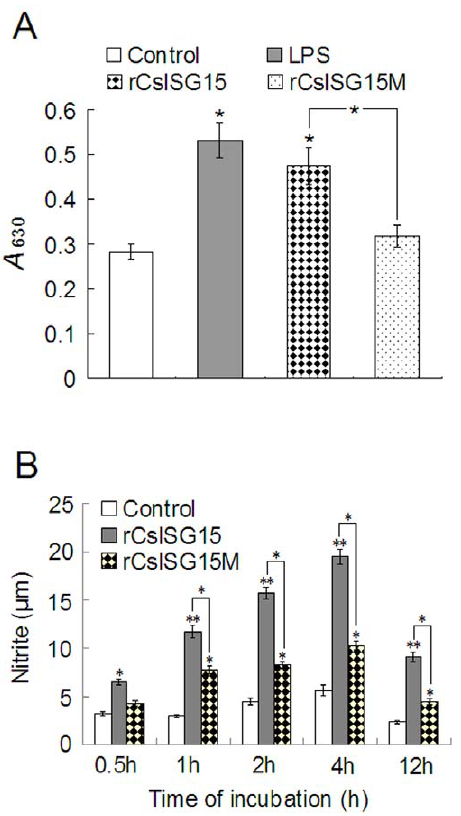
Figure 6. Effect of rCsISG15 and rCsISG15M on macrophage activation. (A) Tongue sole head kidney macrophages were treated with or without (control) rCsISG15, rCsISG15M, or lipopolysaccharide (LPS) for 2 h and examined for respiratory burst. (B) Tongue sole head kidney macrophages were treated with or without (control) rCsISG15 or rCsISG15M for different hours and examined for nitric oxide production. The assays were each performed four times and the results are shown as means 6 SE. ** P , 0.01, * P ,